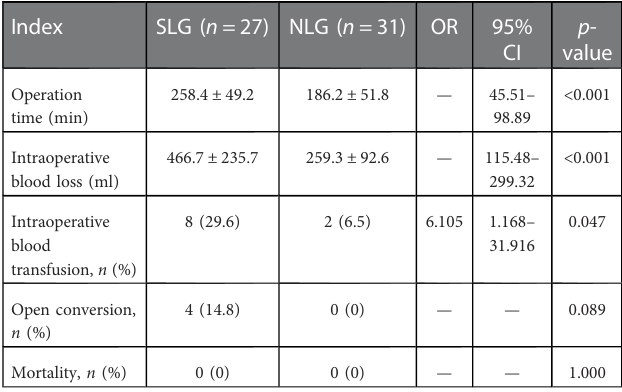
TABLE 2 Intraoperative outcomes of patients between the two groups.